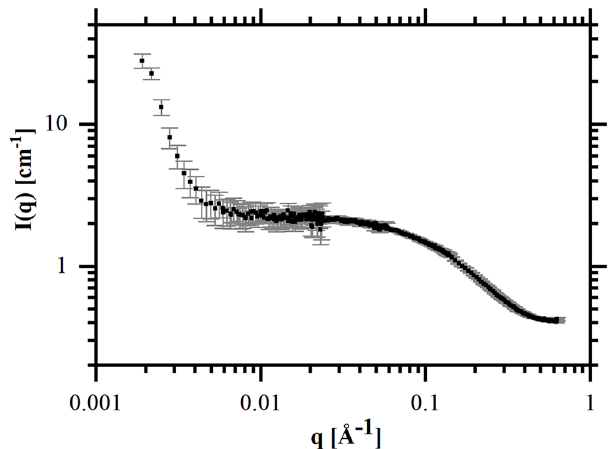
Fig. 11. Example of a rise in low q as seen for some of the samples. This present example was measured with 1.5 M DEHBA diluted in deuterated dodecane charged with 0.5M uranyl. In grey the error bars are presented.